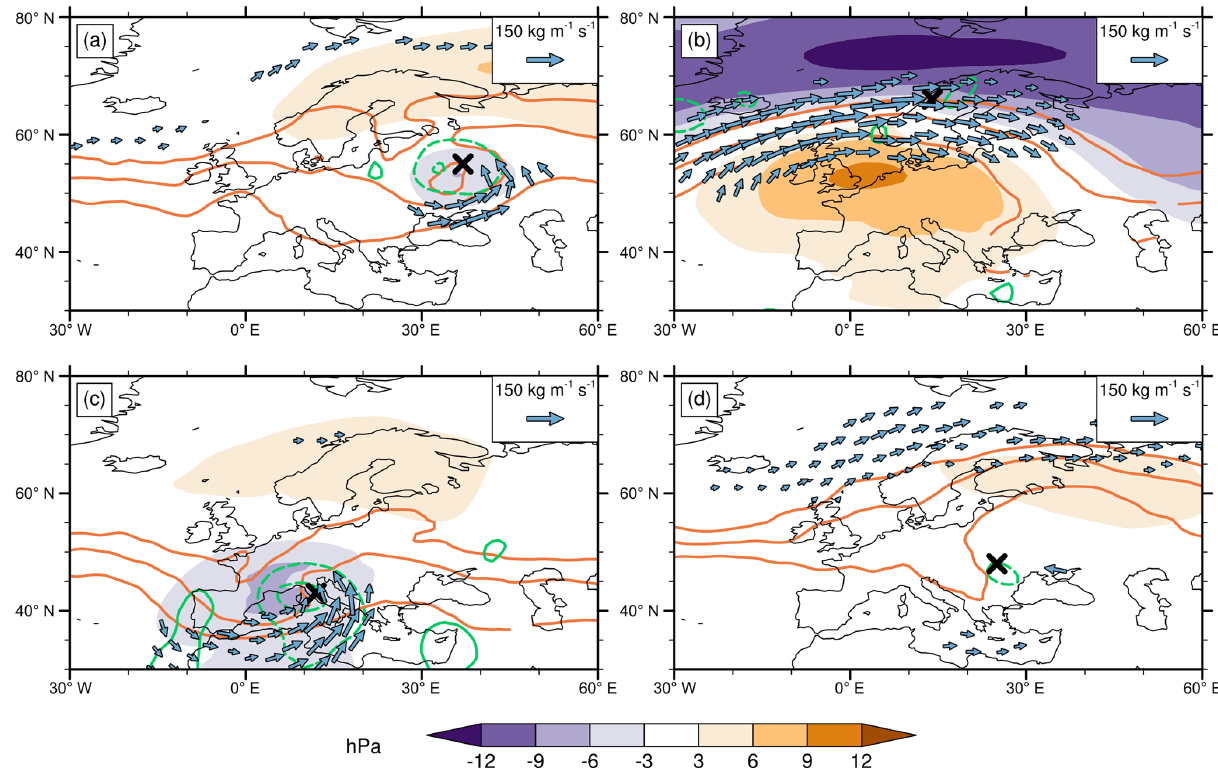
Figure 7. Composites of various fields for the (a) S 20 (55 ◦ N, 37 ◦ E) (Moscow), (b) S 20 (66 ◦ N, 14 ◦ E) (Norway), (c) S 20 (43 ◦ N, 12 ◦ E) (Tuscany), and (d) S 20 (48 ◦ N, 25 ◦ E) (Balkans). Shown are isentropic PV contours of 1, 1.5, and 2PVU (orange contours are masked where the respective isentrope intersects the orography on at least one time step of the respective S 20 ) at (a, c, d) 320K and (b) 310K, as well as SLP anomalies (shading) and QG ω anomalies of − 1.5, − 1, and − 0.5hPah − 1 (dashed green contours) and of + 0.5, + 1, and + 1.5hPah − 1 (solid green contours). Furthermore, vectors depict IVT anomalies whose magnitude exceeds 30kgm − 1 s − 1 . All anomalies are computed relative to a climatology containing data from all calendar days on which at least one of the S 20 at the respective grid point occurred for the 1979–2018 period, i.e. the climatologies vary between the four panels depending on the seasonality and duration of the respective S 20